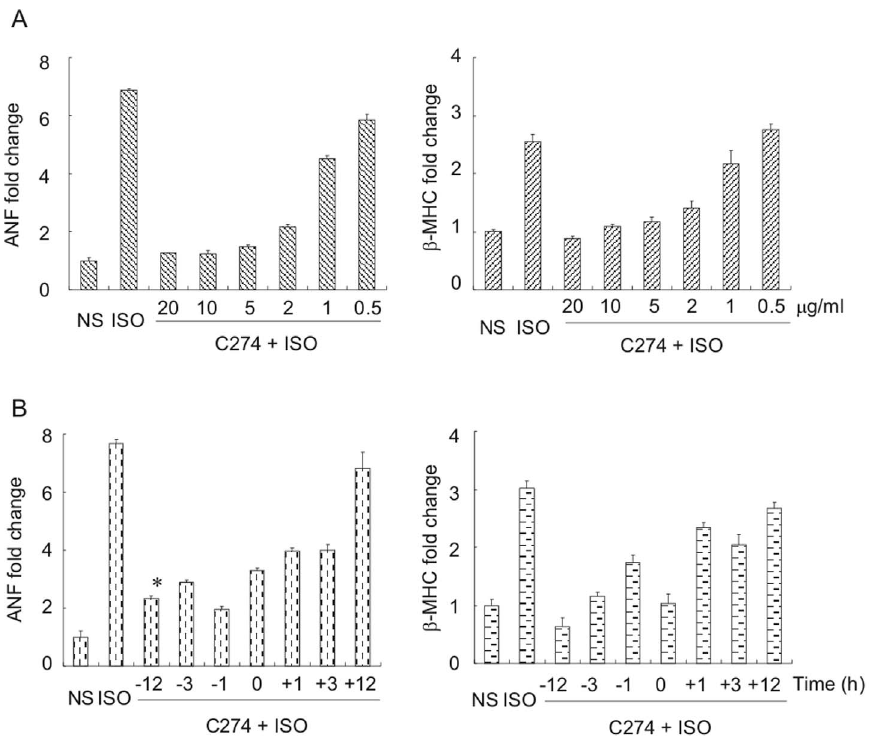
Figure 2. CpG-ODN represses isoproterenol-induced fetal gene reactivation in a dose- and time-dependent manner. (A) Effect of C274 (5 m g/ml) added at different time points on isoproterenol-induced gene reactivation. NRVMs were collected and assayed for ANF and b -MHC expression at different time points as indicated. (B) Dose-dependent effect of C274 on isoproterenol-induced gene reactivation. Myocytes were cultured with various doses of C274 for 12 h and then challenged with isoproterenol (10 m M x 48 h). Cells were collected and assayed for ANF and b - MHC expression. ( # p , 0.01, * p , 0.05 versus isoproterenol group).